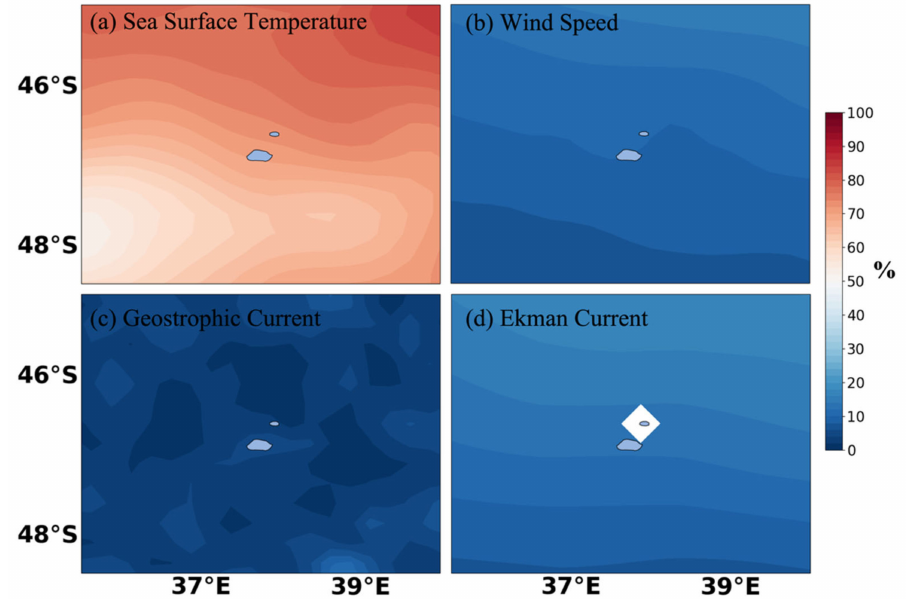
Figure 3. The percentage (%) variance explained by the seasonal cycle of ( a ) Sea Surface Temperature, ( b ) wind speed, ( c ) geostrophic current speed, and ( d ) Ekman current